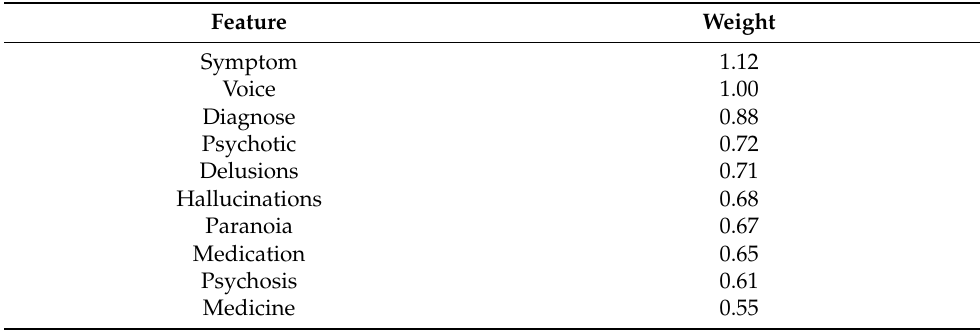
Table 5. Top 10 weighted features from the logistic regression classifier for the schizophrenia and control groups.